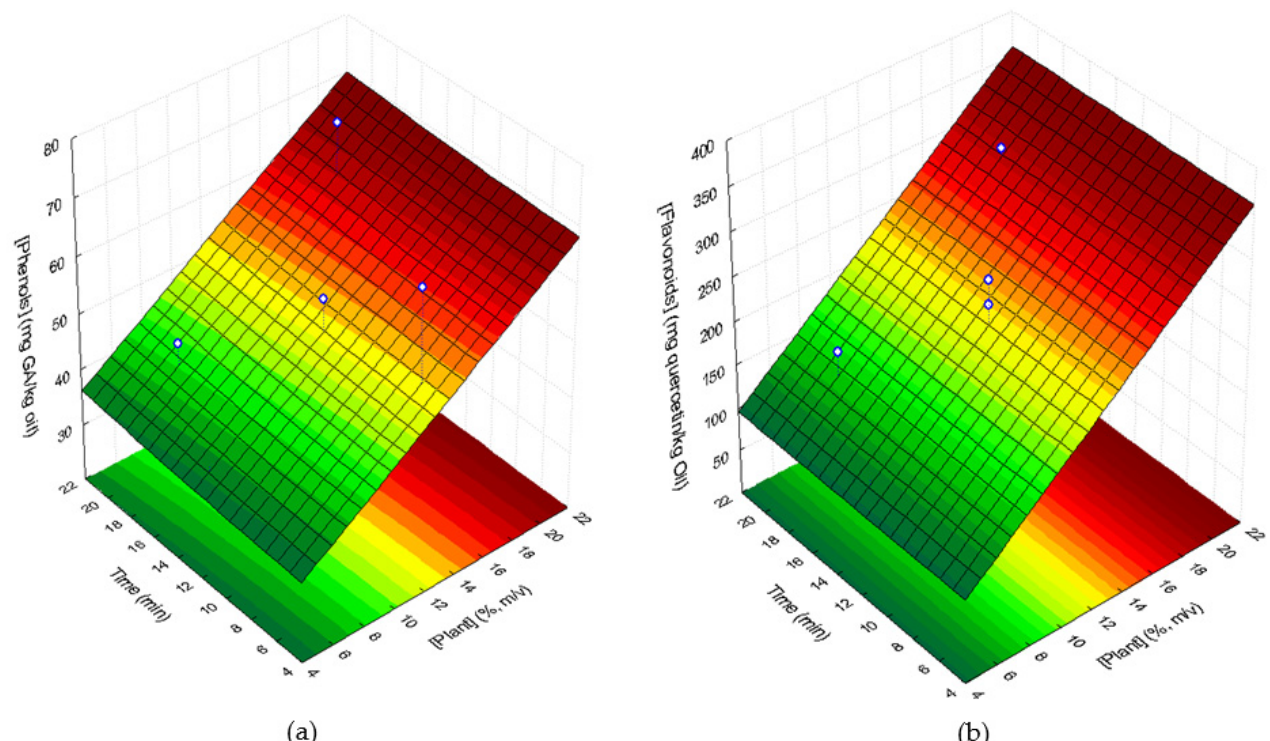
Figure 4. Response surfaces describing the contents of phenolic compounds, expressed in mg gallic acid (GA) equivalent/kg of oil ( a ) and flavonoids, expressed in mg quercetin/kg oil ( b ) of supplemented sunflower oil with lyophilized C. maritimum extracts, as a function of lyophilized C. maritimum concentration and UAE time.